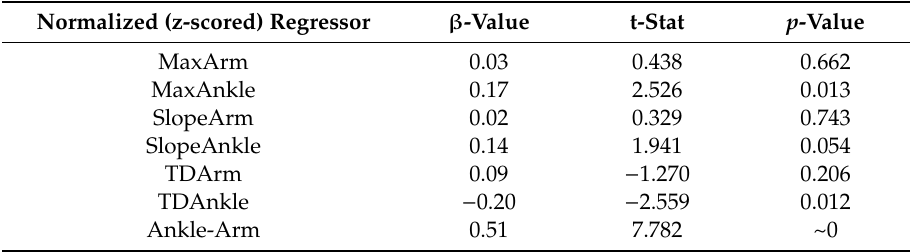
Table 1. Average cross-validated β -values and relative t-scores and p-values estimated through general linear model (GLM) in ankle-brachial index (ABI) prediction.